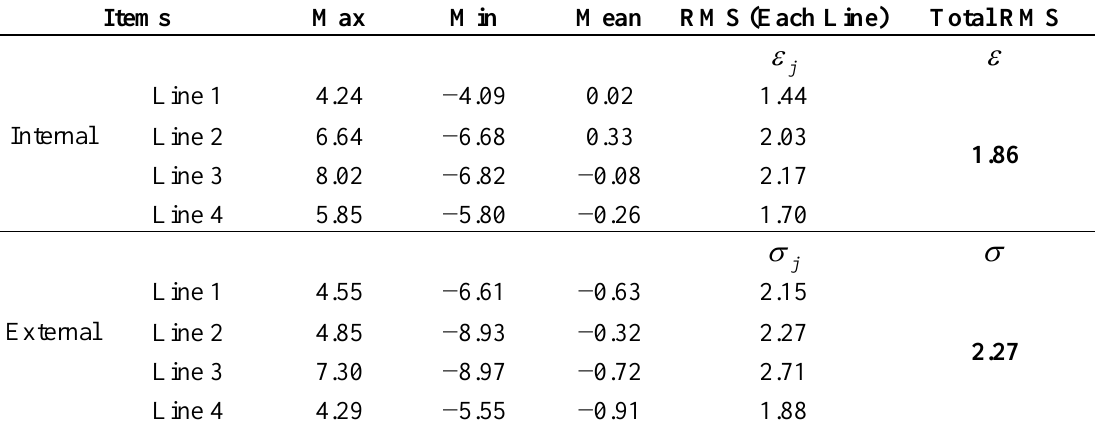
Table 2. Accuracies of 200 s FIR filtered gravity disturbances (Units: